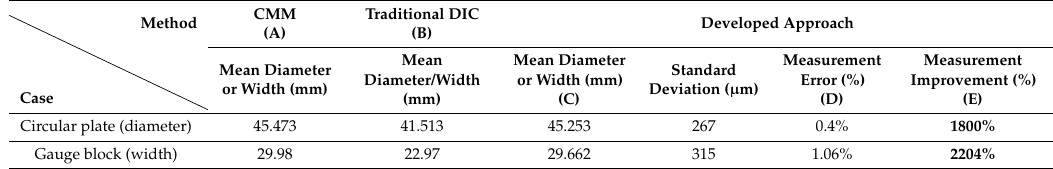
Figure 15. Pre-calibrated circle target reconstructed with edge detection. Table 1. Comparison of measurement accuracy and improvement achieved by coordinate measuring machine (CMM), traditional digital image correlation (DIC) and, the developed approach.